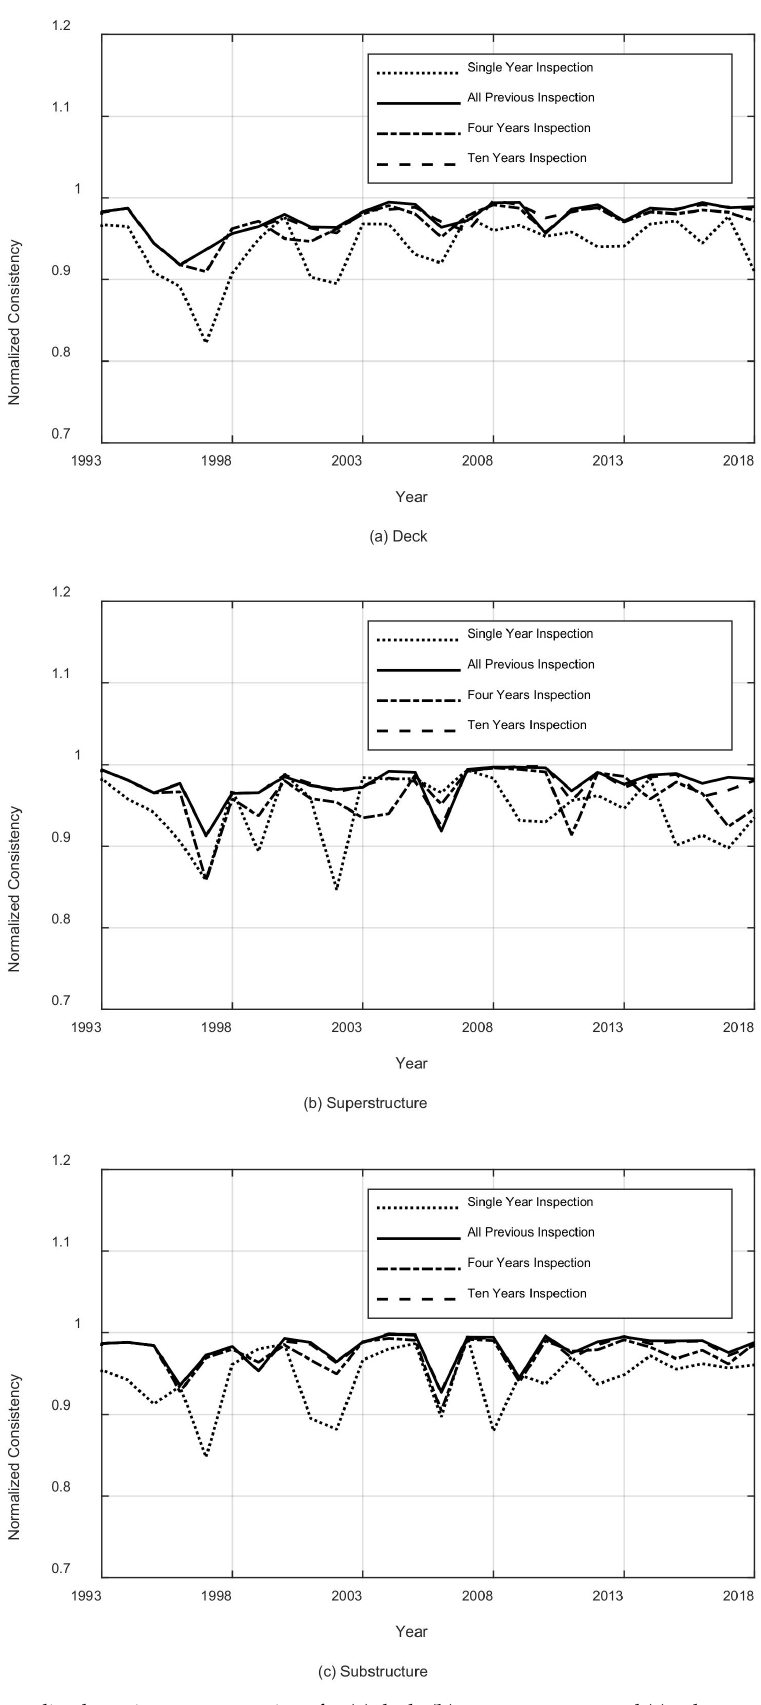
Figure 2. Normalizedconsistencycomparisonfor( a )deck,( b )superstructure,and( c